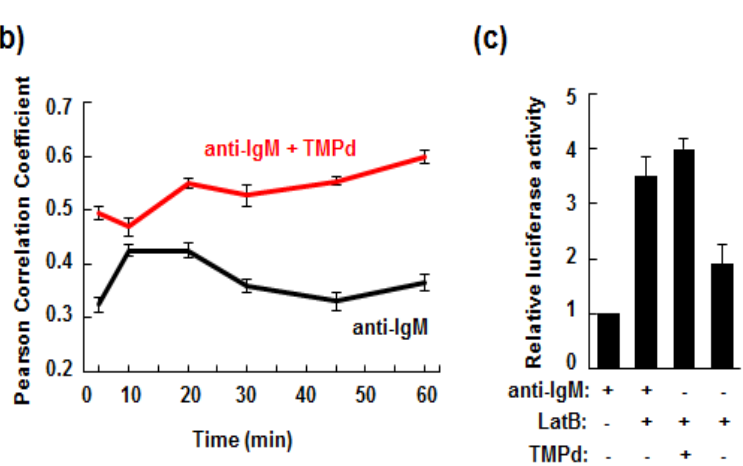
Figure 8. The trimethoprim (TMP) dimer increases the retention of B cell antigen receptor (BCR) complexes. ( a ) DT40 cells stably expressing Myc-SYK-eDHFR were treated with Texas Red-labled anti-IgM (red) with or without TMP dimer for the indicated time points, then fixed, permeabilized and stained with antibodies against SYK (blue); ( b ) Images were analyzed by ImageJ for co-localization of anti-IgM and SYK; ( c ) SYK-dependent DT40 cells transiently transfected with an Nuclear Factor of Activated T cells (NFAT)-driven luciferase reporter plasmid and with a plasmid for the expression of Myc-SYK-eDHFR were activated by receptor crosslinking in the absence or presence of anti-IgM, LatB and/or TMP dimer. Values represent means ± standard error of the mean (SEM) of triplicate assays repeated three times. DMSO, dimethylsulfoxide.